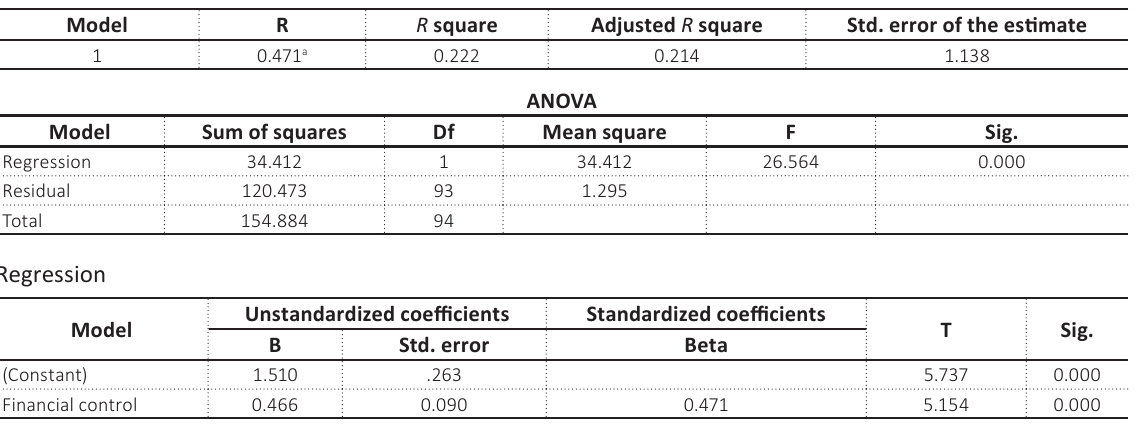
Table 2. Regression analysis